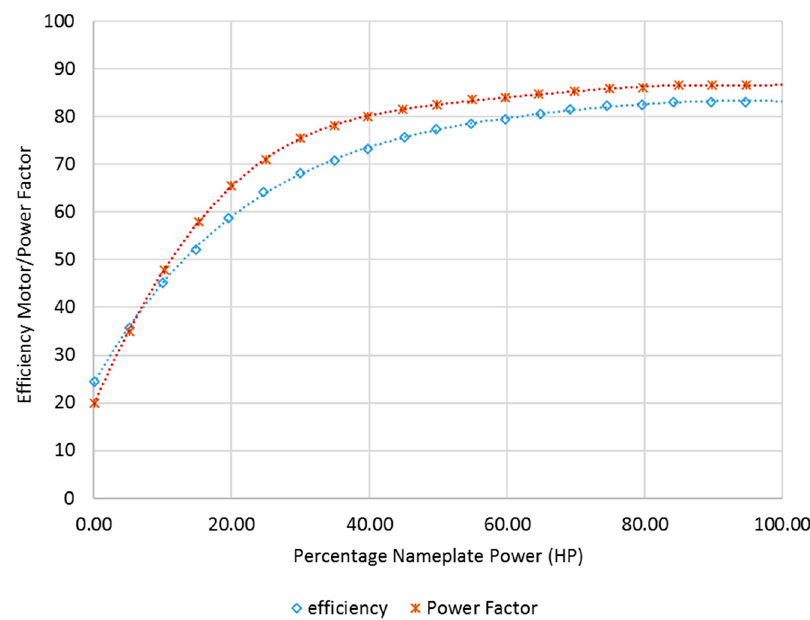
Figure 5. Example ESP motor efficiency curve.